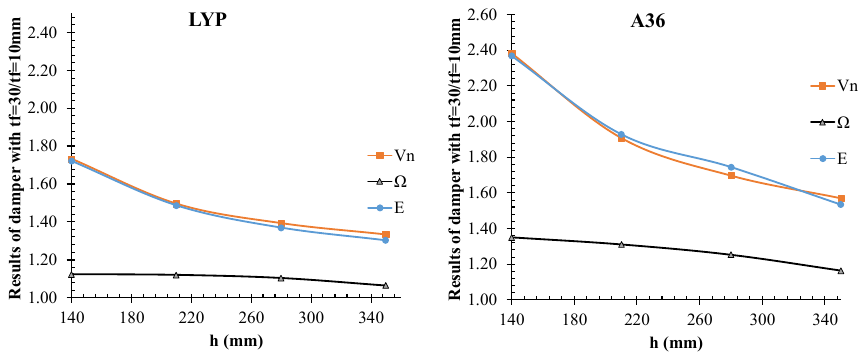
Figure 11. The maximum increase of Vn, Ω , and E versus h.